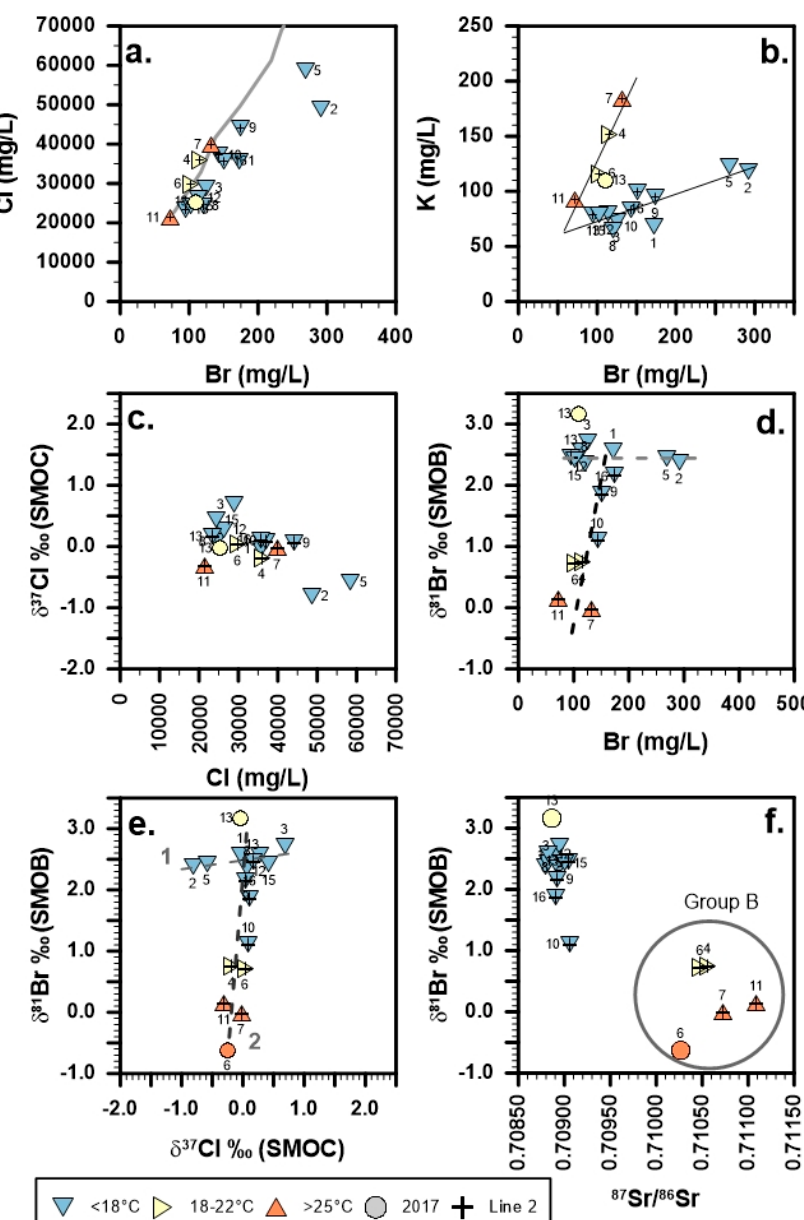
Figure 3. Geochemical and isotopic relationships for Cherokee Basin CBM produced water. Samples from 2013 are represented by triangles pointing in different directions depending on temperature, while 2017 samples are represented by circles, with colors representing temperature following the 2013 symbology. There is a slight excess of Br relative to Cl for most samples relative to water that is derived from evaporated seawater ( a ) (the seawater brine evaporation line of McCaffrey et al. [7] is provided for reference (light grey)). Two trends are evident when comparing K vs. Br (b). The trends in panel ( b ) have correlation coefficients of 0.92 and 0.70 for the fluids warmer than 18 ◦ C and cooler than 18 ◦ C, respectively. Panels ( c , d ) illustrate δ 37 Cl vs. Cl and δ 81 Br vs. Br, respectively. Two trends are also evident when comparing δ 81 Br vs. δ 37 Cl (e). Line 2 ( e ) is a mixing line, but the process resulting in Line 1 is less certain (see Discussion). In panels ( a – d ), samples with a ‘+’ symbol denote those that fall along line 2 in panel ( e ). In panel ( f ), δ 81 Br vs. 87 Sr/ 86 Sr, the strong relationship between temperature, δ 81 Br, and 87 Sr/ 86 Sr in Group A and Group B samples (circled group) is evident. Group B samples (see Table S3 and discussion in text) are the four samples with temperatures above 18 ◦